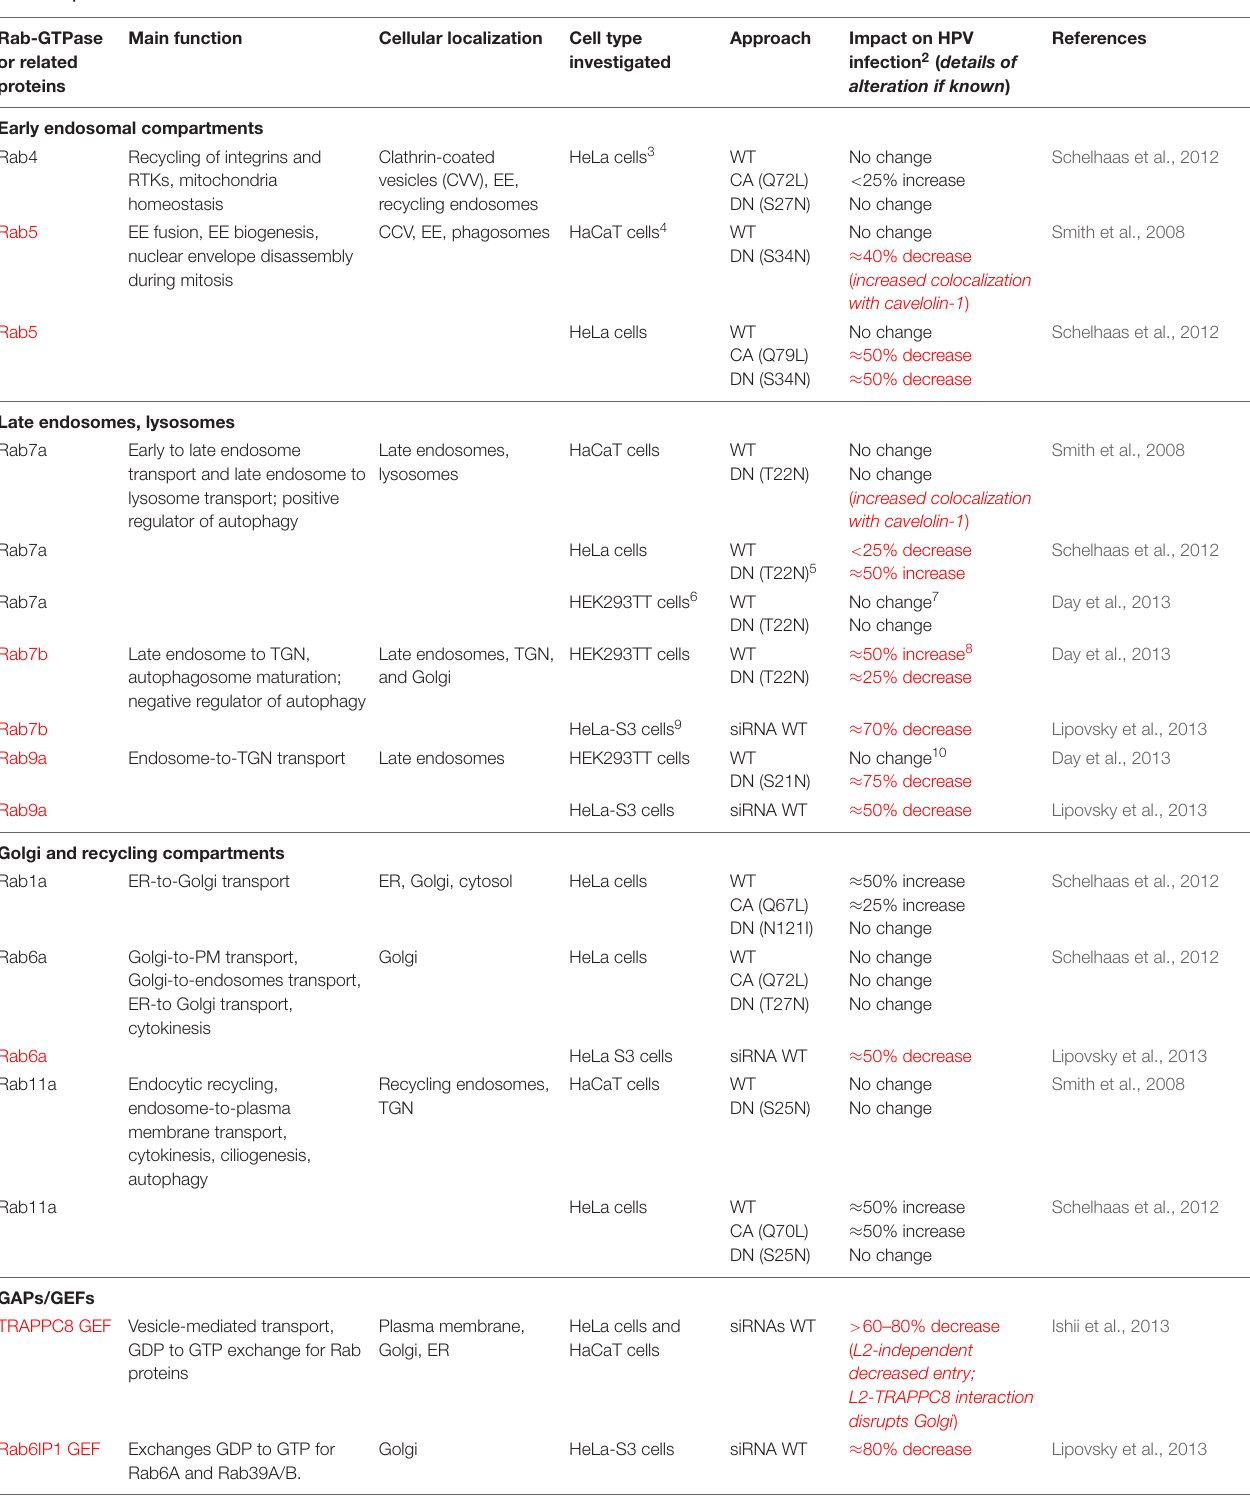
TABLE 1 | Rab-GTPase and related GTPase Involvement in HPV infection 1